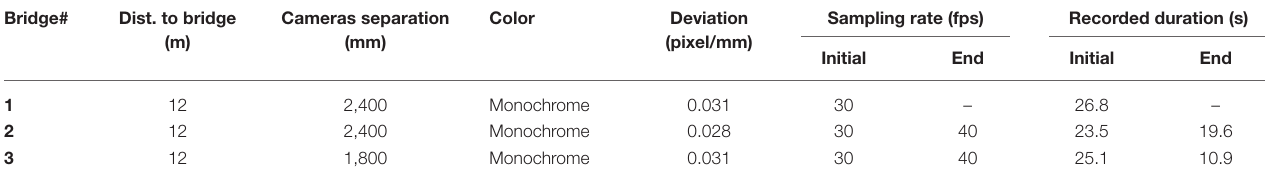
TABLE 2 | Monitoring